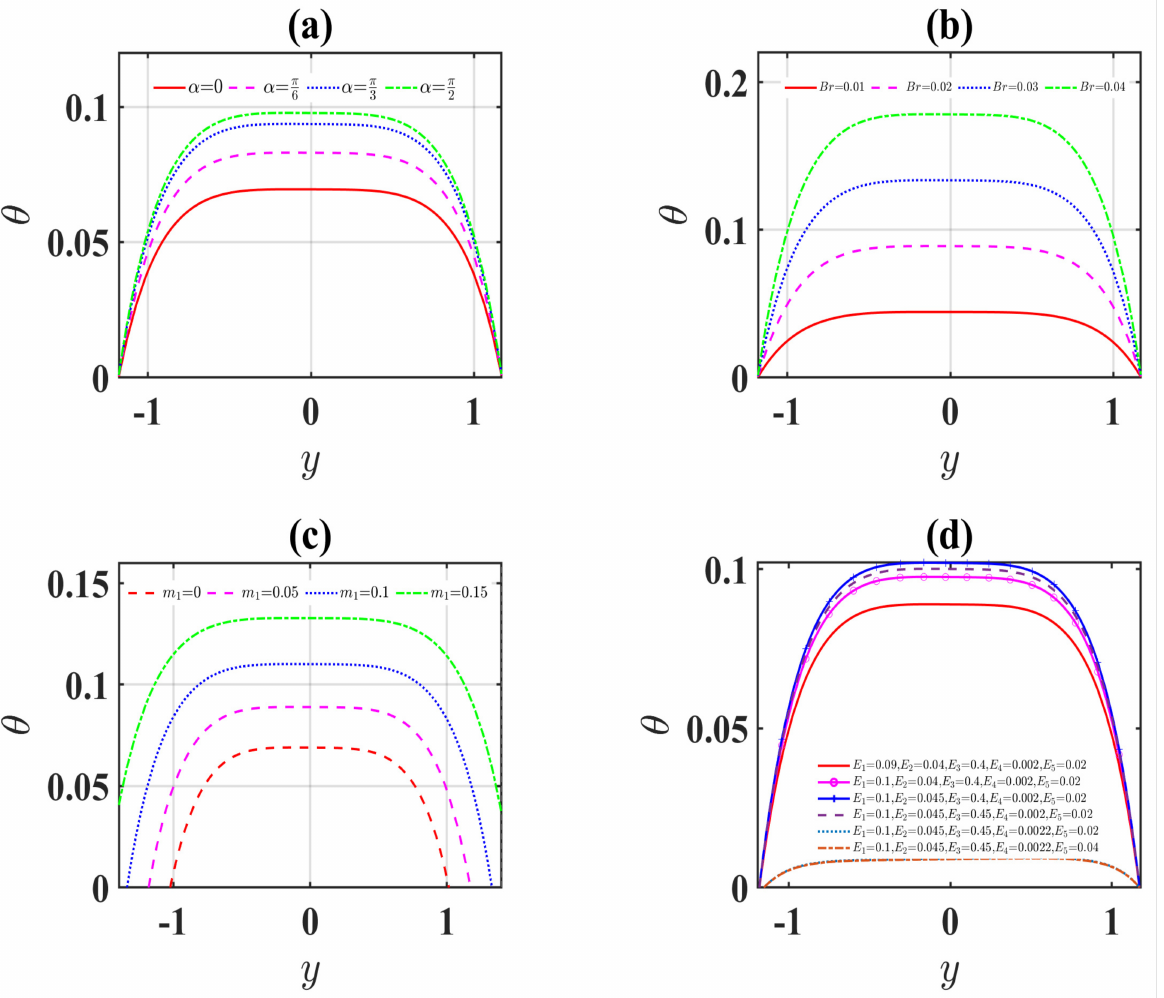
Figure 4. Temperature profiles for varying ( a ) α , ( b ) Br , ( c ) m 1 , and ( d ) E 1 − E 5